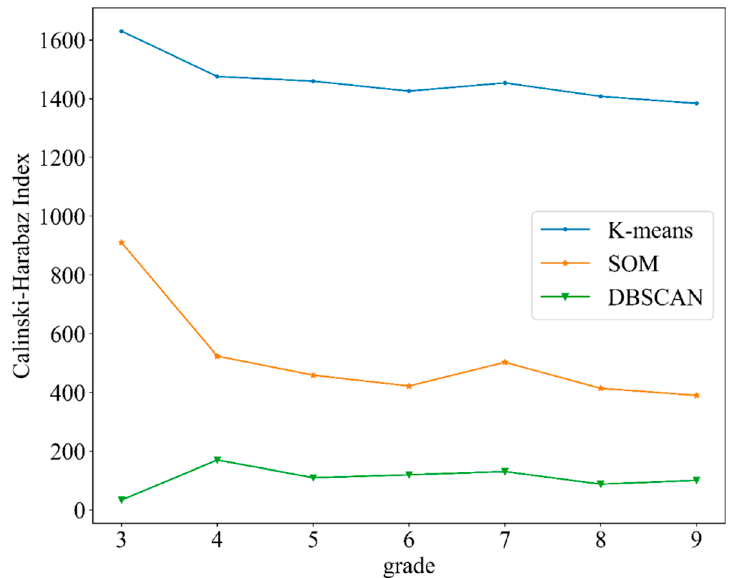
Figure 6. CH index of different algorithm rankings.